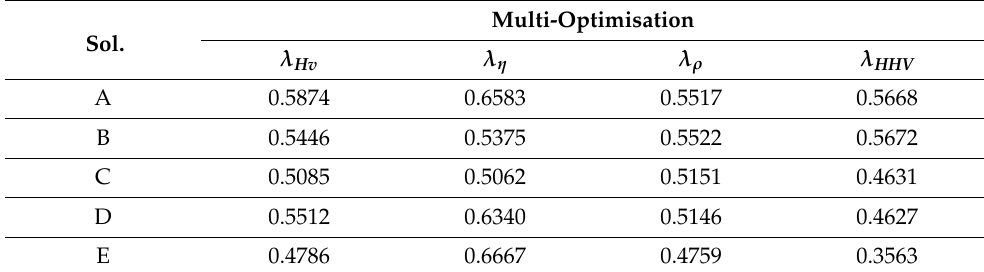
Table 7. Comparison of λ p between different product